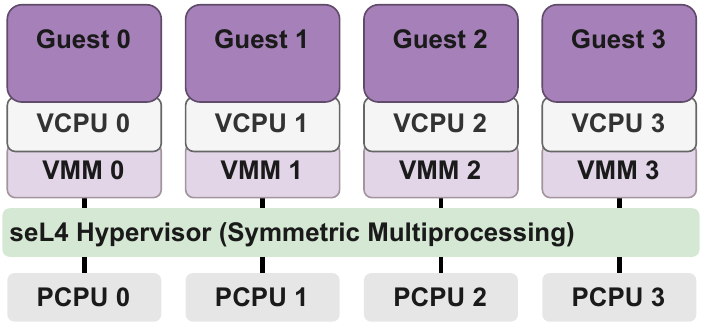
Figure 3. Direct Mapping Configuration